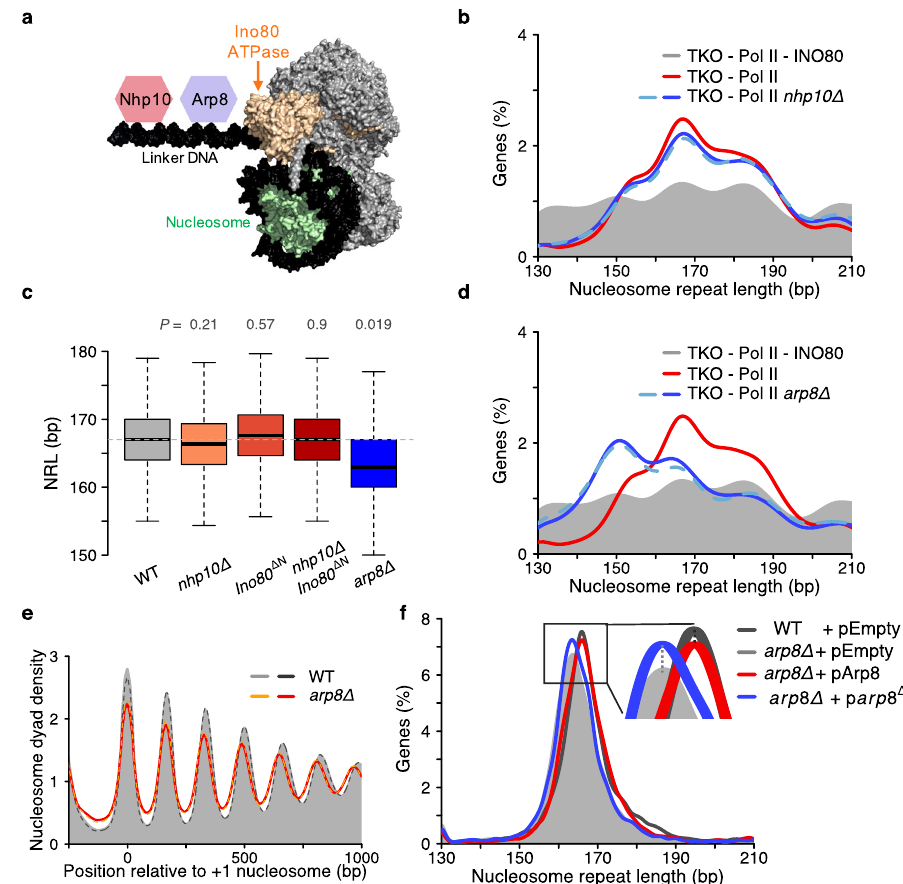
Fig. 4 Arp8, but not Nhp10, regulates INO80-mediated spacing in vivo. a Cartoon of the INO80 complex bound to the nucleosome based on PDB code 6FML https://www.rcsb.org/structure/6fml. The Nhp10 and Arp8 modules interact with linker DNA. b Deletion of NHP10 (blue lines) does not substantially alter the NRL distribution in TKO-Pol II samples (red; all colored lines peak at 167 bp). Cells depleted for INO80 are shown as a reference (grey). c Box plots of measured NRLs in the indicated single and double mutants in otherwise WT cells. Horizontal line is at 167 bp. P values are from a two- tailed paired Welch ’ s t-test on the mean values of two replicates compared to WT. d Same as b , but for arp8 Δ . The NRL distribution shifts left peaking at 151 bp. e ARP8 deletion affects the amplitude and NRL of arrays. f ARP8 deletion shifts the NRL distribution to shorter values (peaks at 163 bp for arp8 Δ and 166 bp for WT cells). This effect can be faithfully rescued by expression of wild-type Arp8 but not Arp8 lacking amino acids 2 – 197 (dashed lines). pEmpty: empty vector. Central line in box plot indicates the median, the box shows the interquartile range, and whiskers indicate data points within 1.5 times of the interquartile